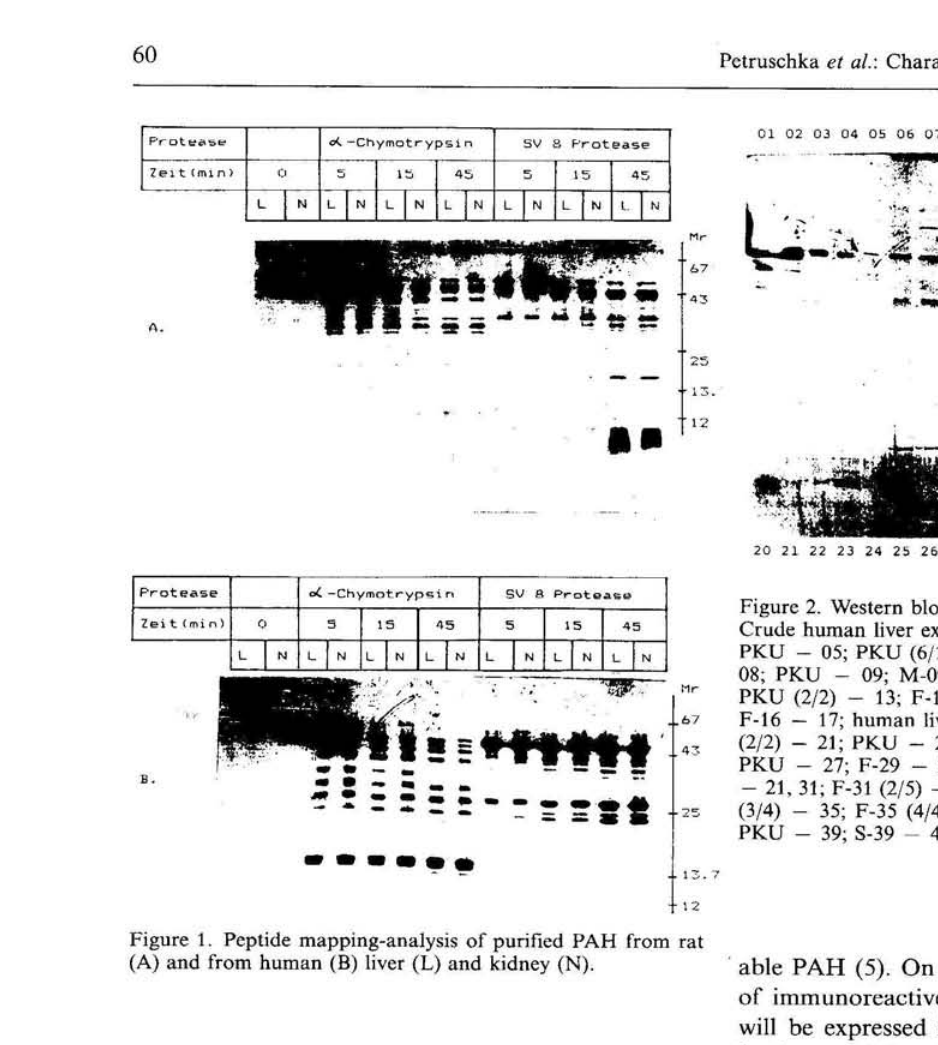
Figure 1. Peptide mapping-analysis of purified PAH from rat (A) and from human (B) liver (L) and kidney (N).